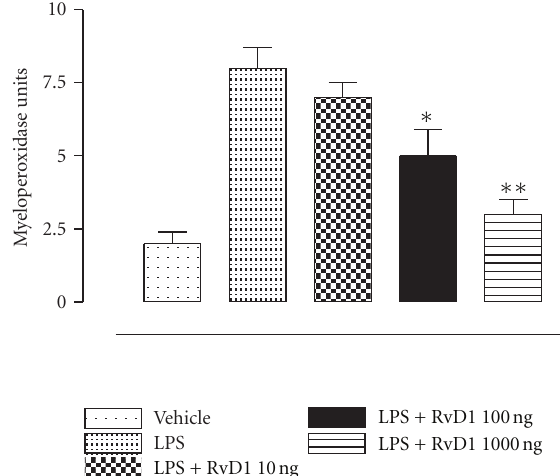
Figure 5: E ff ects of resolvin D1 treatment on MPO activity. The rats were treated with vehicle (PBS) and resolvin D1 (RvD1; 10, 100, 1000 ng/kg) 1h after LPS (200 μ g/rat). Data are expressed as mean ± SE; n = 6 per group. ∗ P < 0 . 05 and ∗∗ P < 0 . 01 compared with LPS-treated